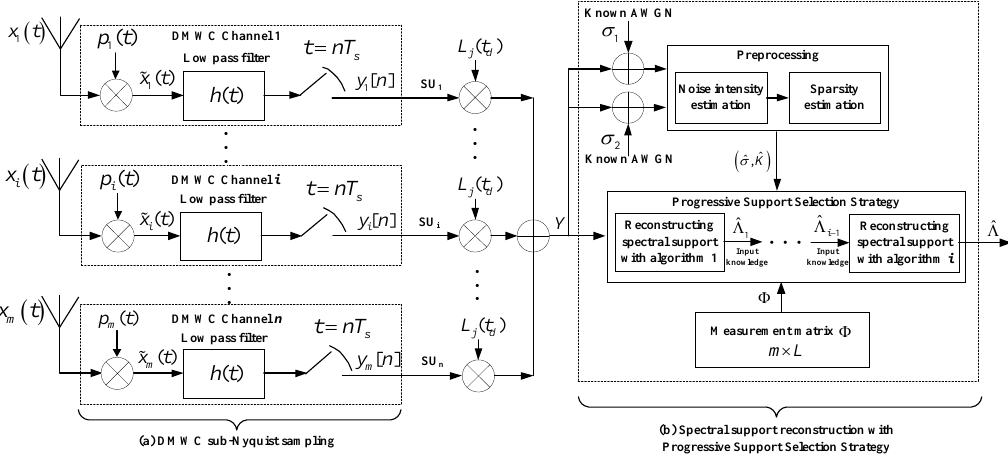
Figure 9. The structure of the PSS-SaDMWC scheme. ( a ) DMWC sub-Nyquist sampling; ( b ) Spectral support reconstruction with progressive support selection strategy.